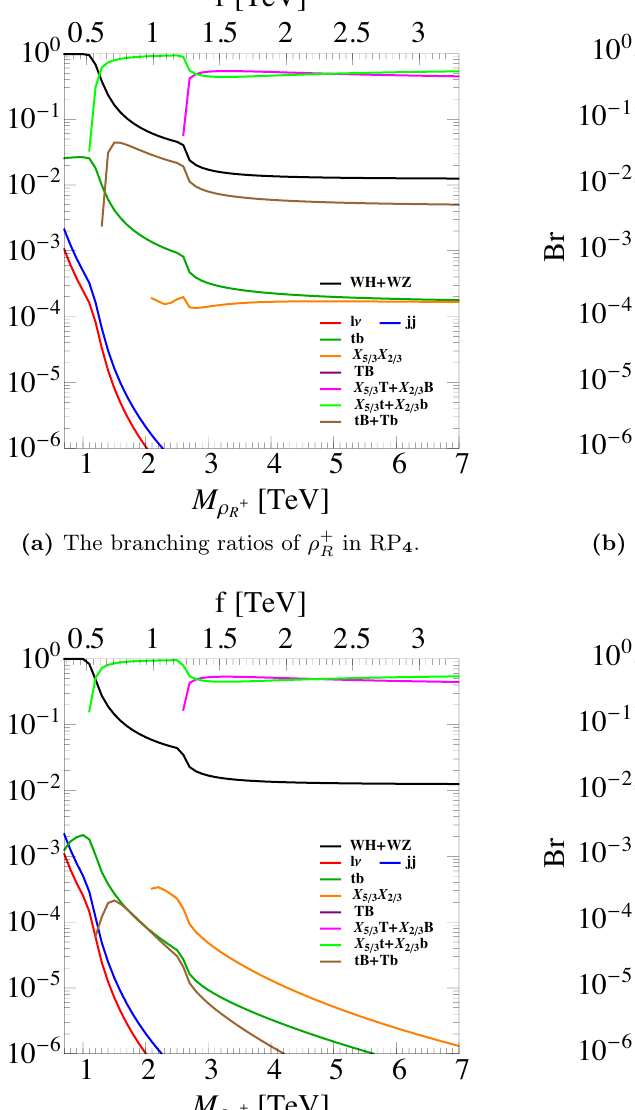
O ( g (cid:24) ). As a consequence, the (cid:26) + (cid:26) R In the intermediate mass region, the decaying into X all the other channels with branching ratio larger than 90% in both model LP as their left-handed couplings arise before EWSB. The decay channels into t (cid:22) B + T (cid:22) b are very small (2% (cid:0) 4%) for model LP